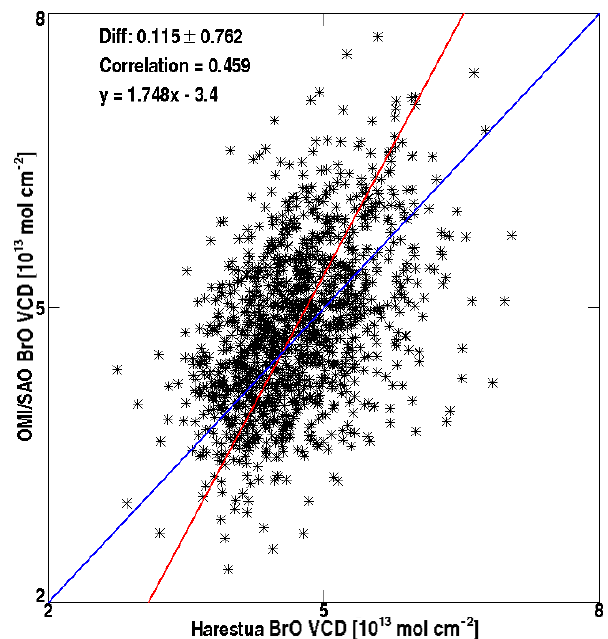
Figure 9. Correlation and orthogonal regression of OMI and Harestua BrO for the data in Fig. 8. The legends show the mean biases and standard deviations of the differences, correlation and the orthogonal regression.